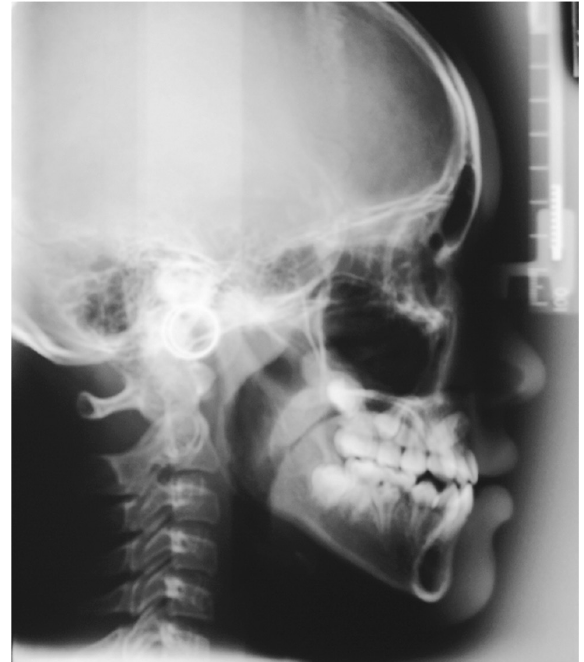
Figure 3. Pre-treatment panoramic radiograph.